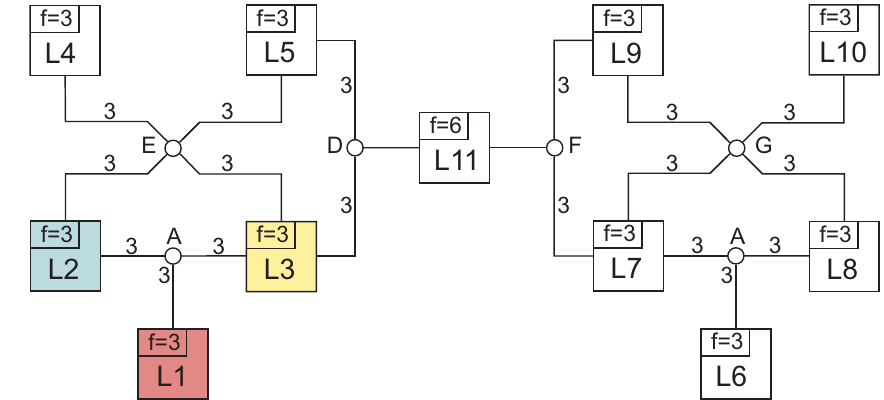
Figure 6. The undirected kinematical network of the “double-banana” mechanism.